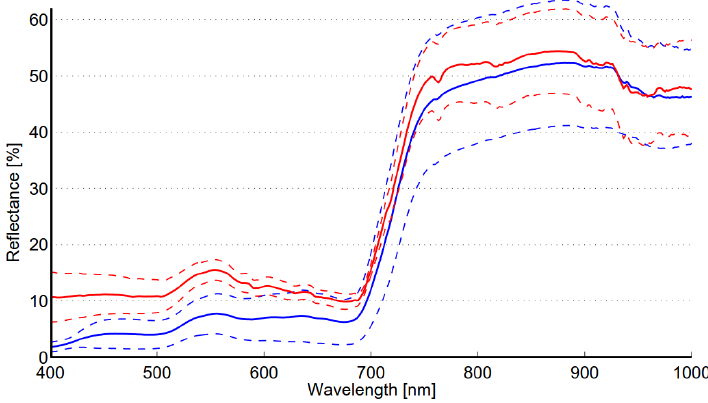
Figure 5. Mean and standard deviation of the reflectance spectra of meadow (blue) and reed bed (red) classes. The standard deviation is presented using dashed lines.